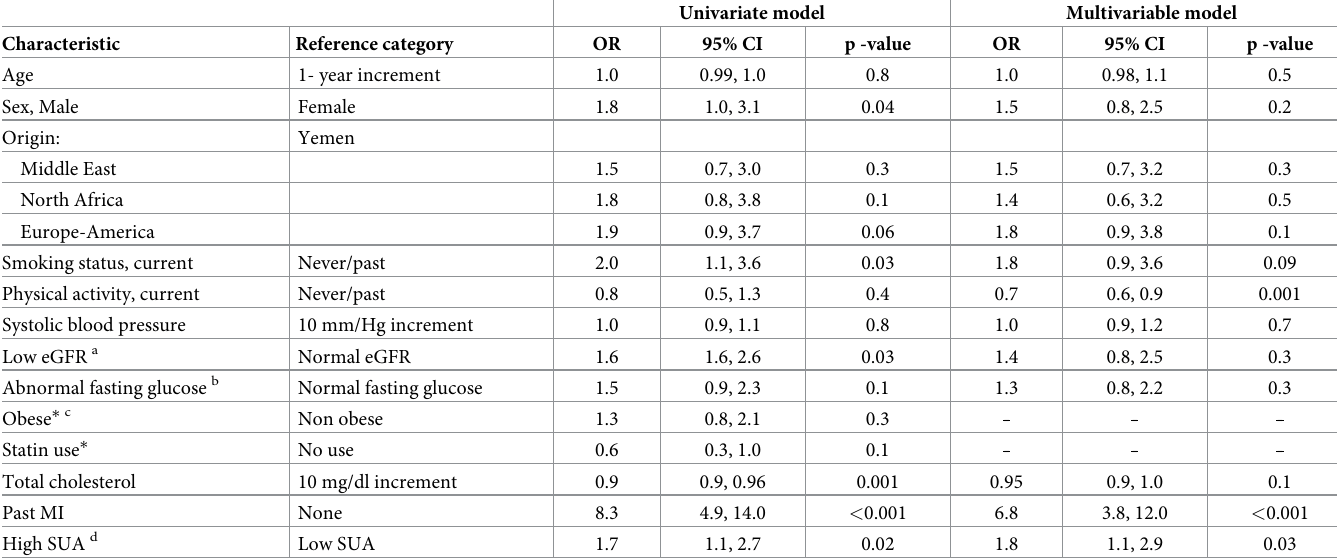
Table 2. Logistic regression models for the association between serum uric acid and ischemic changes on